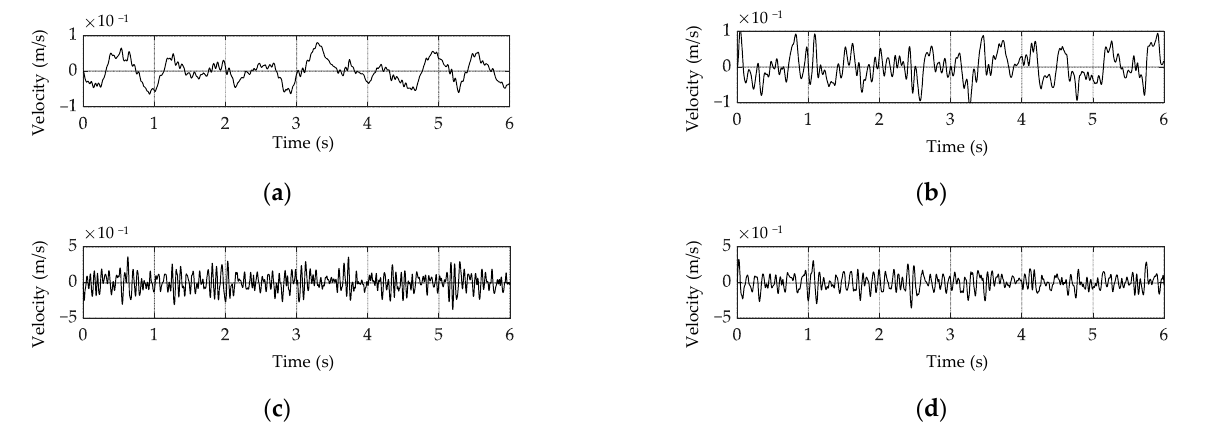
Figure A1. The velocity responses obtained in Scenario 1: ( a ) 𝑧(cid:4662) (cid:3046)(cid:2869) ; ( b ) 𝑧(cid:4662) (cid:3046)(cid:2870) ; ( c ) 𝑧(cid:4662) (cid:3048)(cid:2869) ; and ( d ) 𝑧(cid:4662) (cid:3048)(cid:2870) .